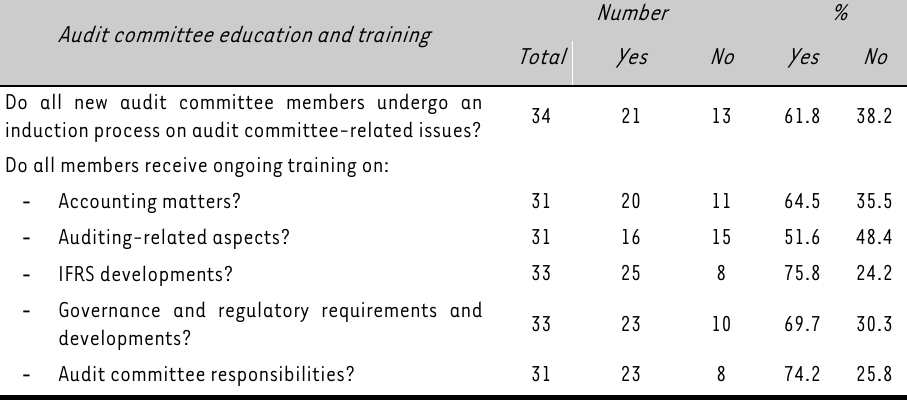
TABLE 5: Audit committee education and